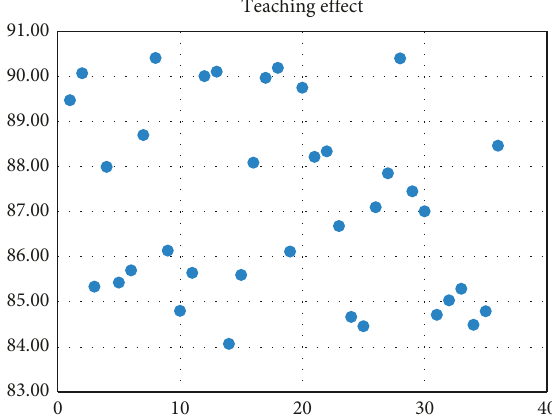
Figure 12: Teaching effect